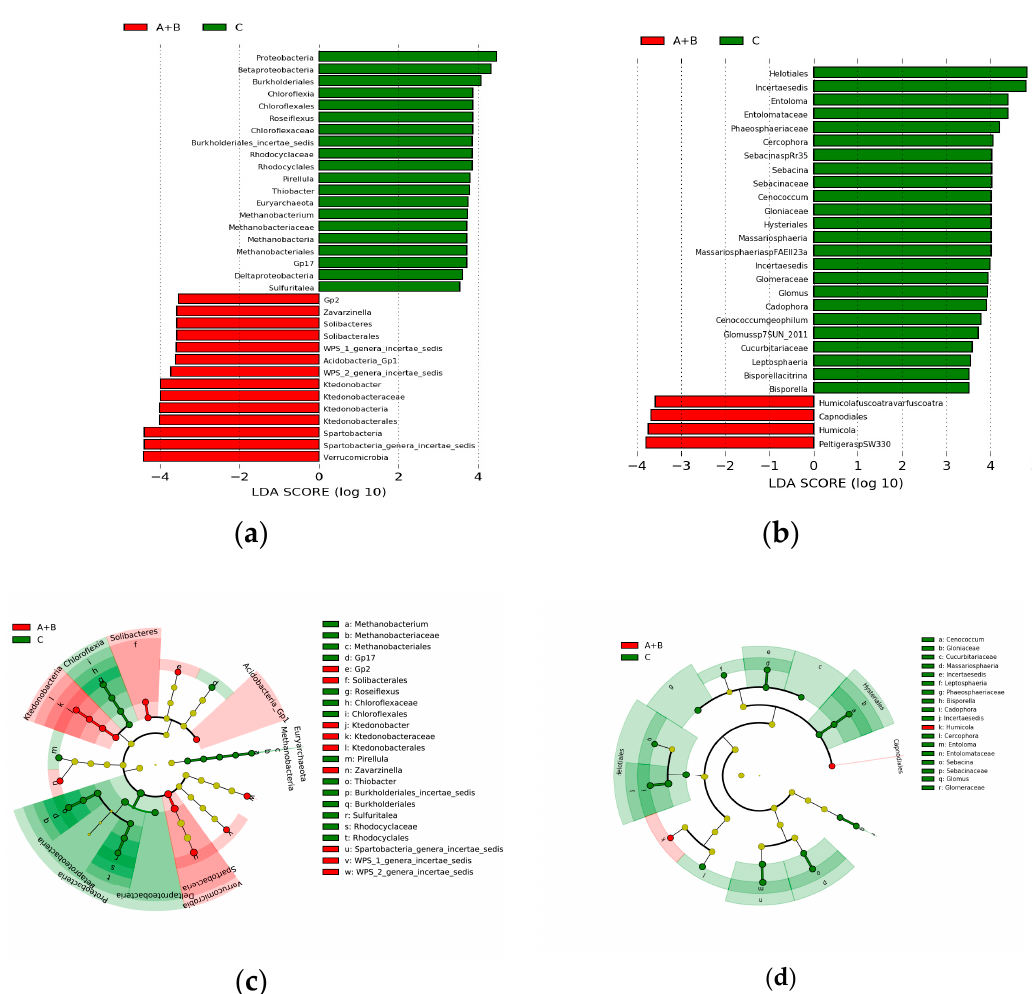
Figure 6. Differentially abundant microbial taxa in Chinese Cordyceps group (sites A and B) and null Chinese Cordyceps group (site C) illustrated using linear discriminant analysis (LDA) effect size analysis and cladograms for ( a , c ) bacteria and ( b , d ) fungi. Red represents taxa-enriched in sites A and B, green represents taxa-enriched in site C. Microbial taxa were determined by LDA with a significant threshold over 3.5.